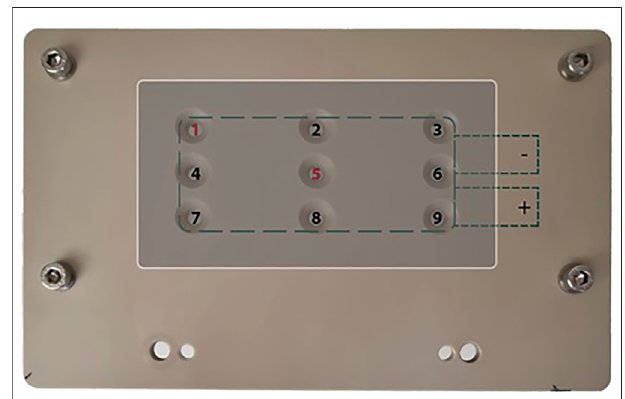
FIGURE 1 | Image of the pouch cell holder showing the nine measurement positions as holes in the holder, and the location of the pouch cell (gray) and electrode (25 cm 2 ) and tab positions (dashed lines). The electrode tabs exited the holder from slots on the back of the holder (not shown here). The X-ray beam in the direction perpendicular tothe plane of the page. 1 and 5 are highlighted red as points of interest in the Results and discussion